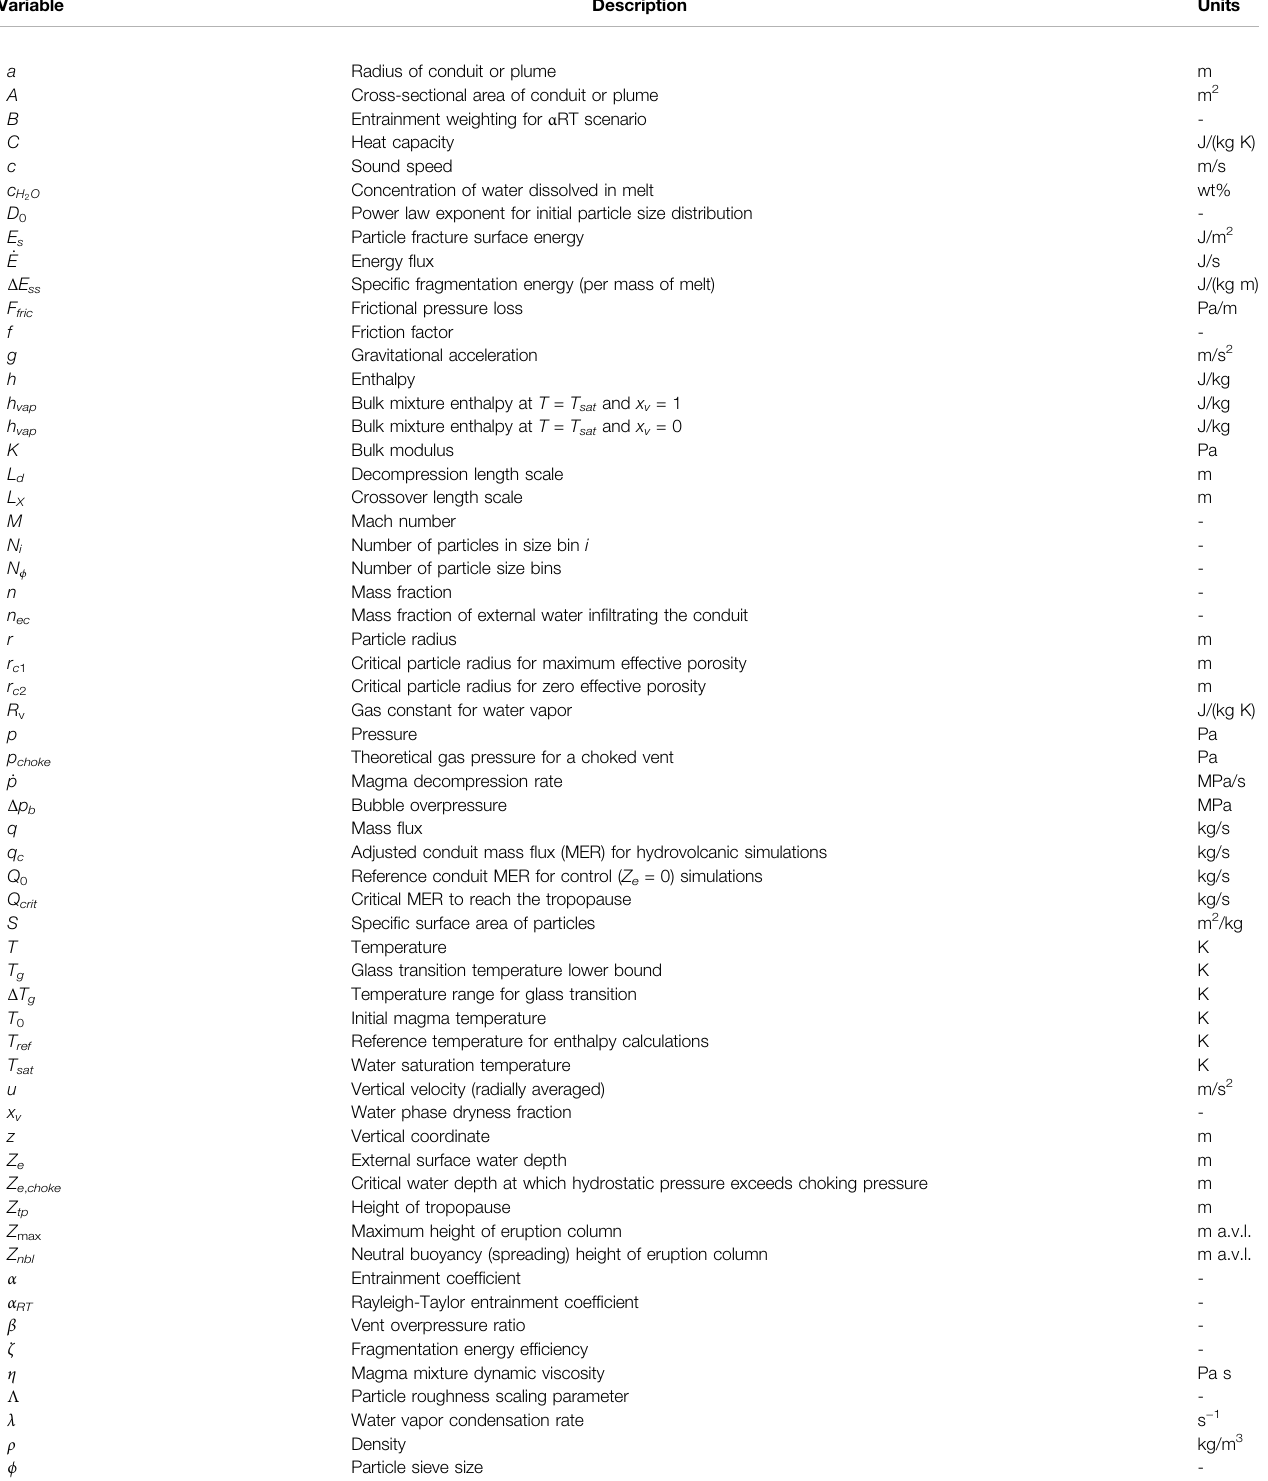
TABLE 1 | List of variables and subscript